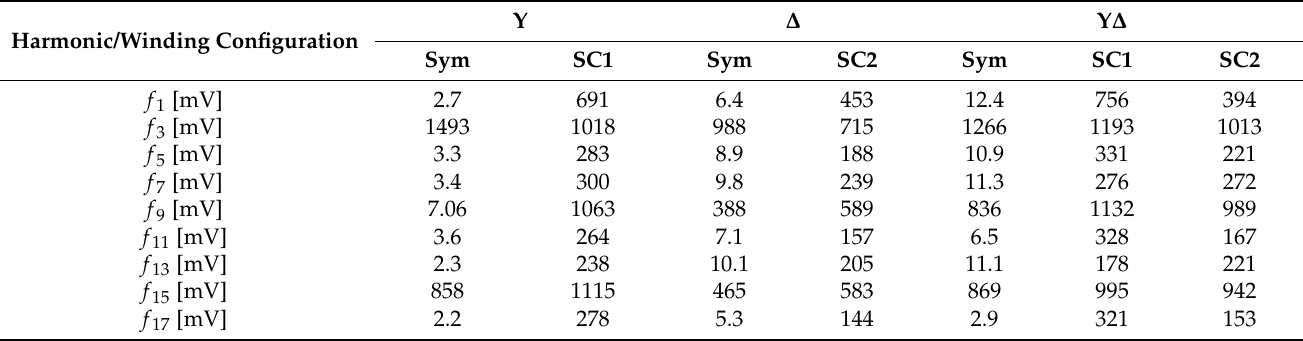
Table 6. FFT of u 0 —numerical